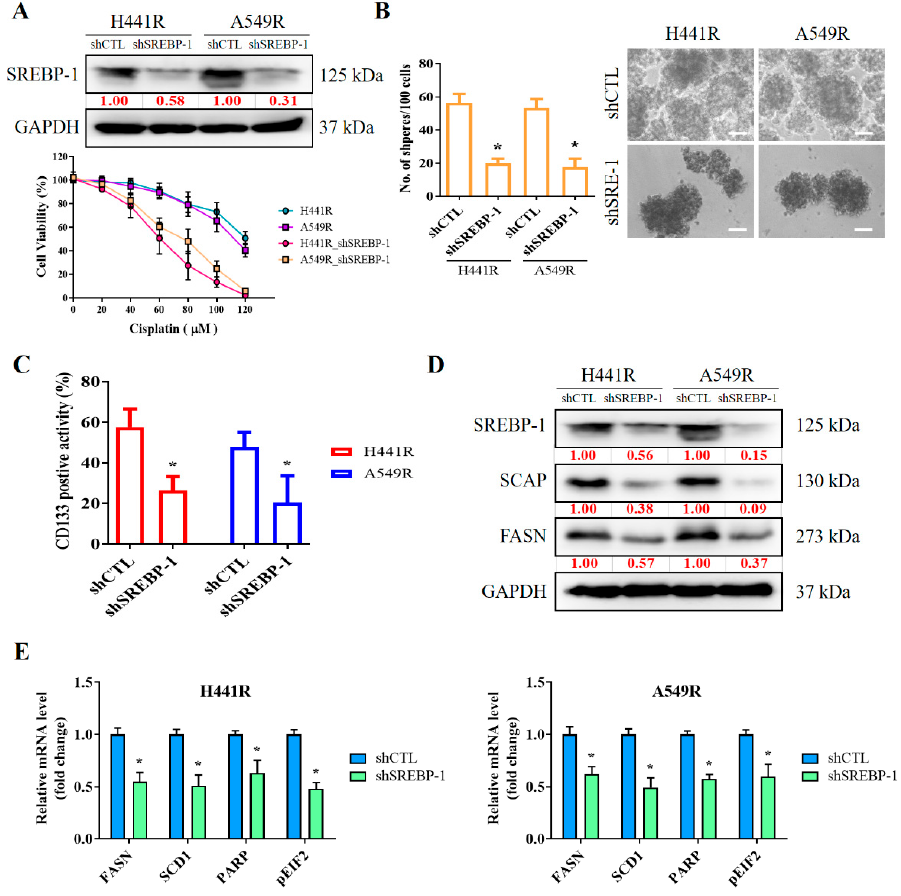
Figure 4. Silencing SREBP-1 attenuated the viability and stemness of H441R and A549R cells. ( A ) Western blot images indicating the knockdown efficacy of shSREBP-1 in H441R and A549R cells. Graphical representation of the effect of cisplatin on A549R, A549R_shSREBP-1, H441R, and H441R_shSREBP-1 cells, as determined through MTT assays. ( B ) Images and graphs of the effect of shSREBP-1 on the number and size of spheres formed by A549R and H441R cells. ( C ) Flow cytom- etry images indicating how shSREBP-1 affects the percentage of ALDH1+ A549R and H441R cells. ( D ) Western blot analysis images revealing the effect of shSREBP-1 on the expression of SREBP-1, SCAP, FASN, and SREBP2 in transfected A549R and H441R cells relative to their VC counterparts. ( E ) Graphical representation of the effect of shSREBP-1 on the levels of FASN, SCD1, cleaved PARP, and peIF2 α in A549R and H441R cells. VC, vector control. Results are represented as means ± SDs from assays performed three times in triplicate. * p < 0.05. 2.6. Increased SREBP-1/SCAP/FASN Signaling Is Implicated in the Reduced Sensitivity of NSCLC Cells to Cisplatin Finally, we validated our in vitro findings by using our own NSCLC cohort, which consisted of 20 pairs of cisplatin-sensitive and cisplatin-resistant clinical samples. Con- sistent with our aforementioned findings, according to the results of IHC staining, the cisplatin-resistant samples exhibited significantly higher levels of SREBP-1 (1.5-fold, p < 0.001), SCAP (1.86-fold higher, p < 0.001), and FASN (1.76-fold, p < 0.001) expression than did the cisplatin-sensitive samples (Figure 5A). The qRT-PCR analysis supported the IHC staining results at the mRNA level (Figure 5B).